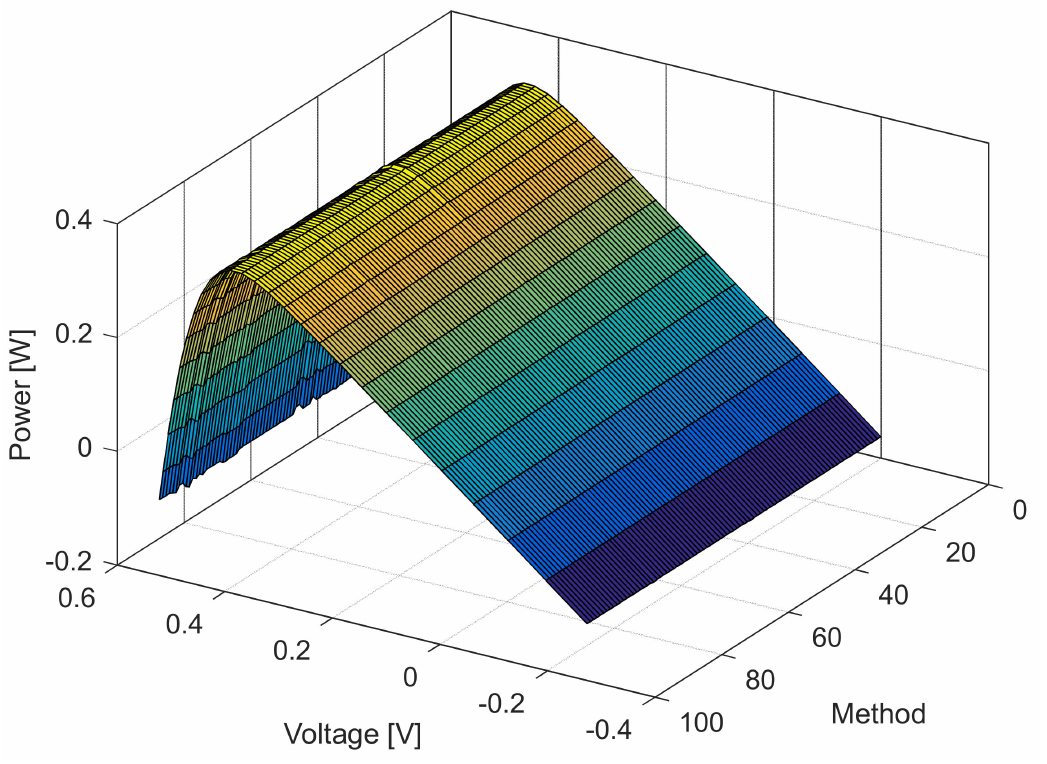
Figure 8. Power–voltage characteristics for the methods listed in Table 2.